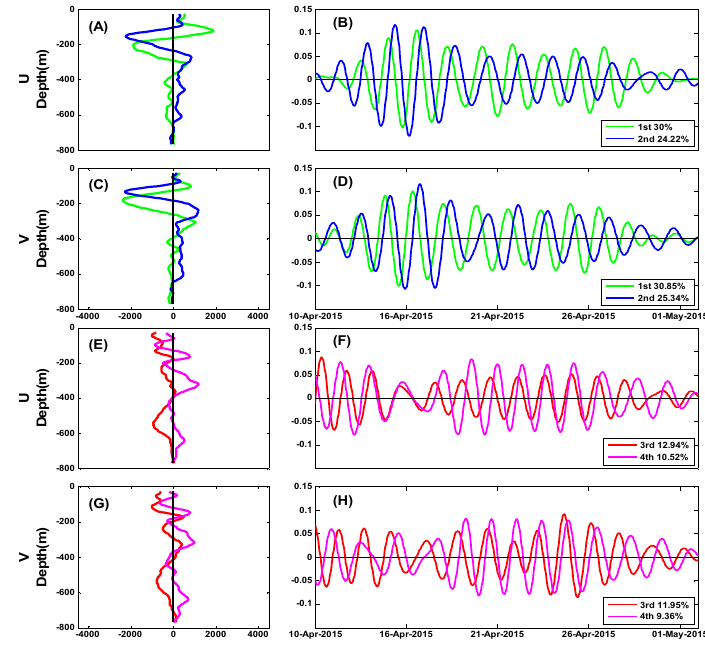
Figure 9. As for Figure 8 but for the NIO event in April 2015.